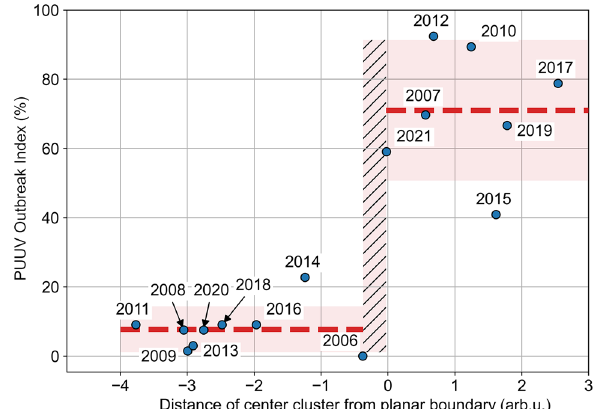
Figure 4. Estimating the PUUV Outbreak Index from the classification model. The proportion of districts with high risk for each year, which was defined as the PUUV Outbreak Index, is plotted with respect to the distance from the planar boundary of the cluster centers, i.e., of the points defined by the average values of the weather parameters over Germany for that year. The red dashed lines show a piecewise constant fit to the data (pseudo-R 2 = 0.87, calculated according to 15 ). The red-shaded area indicates the uncertainty. The hashed area for distances in the interval [ − 0.37, − 0.03] represents the increased uncertainty about the position of the